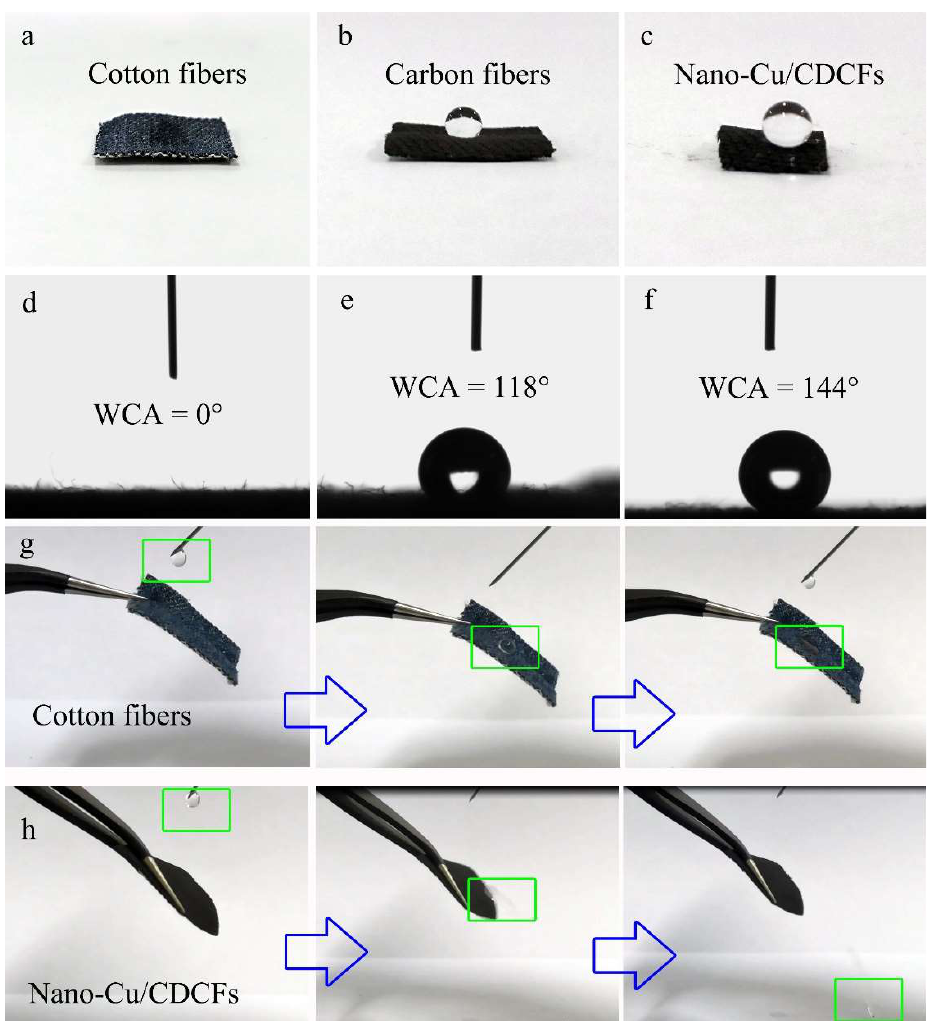
Figure 4. Hydrophobic property and WCA tests of the cotton fibers ( a , d ), CDCFs ( b , e ) and nano-Cu/CDCFs ( c , f ), respectively. Photographs of water drop contacting the surfaces of the cotton fibers ( g ) and nano-Cu/CDCFs ( h ).